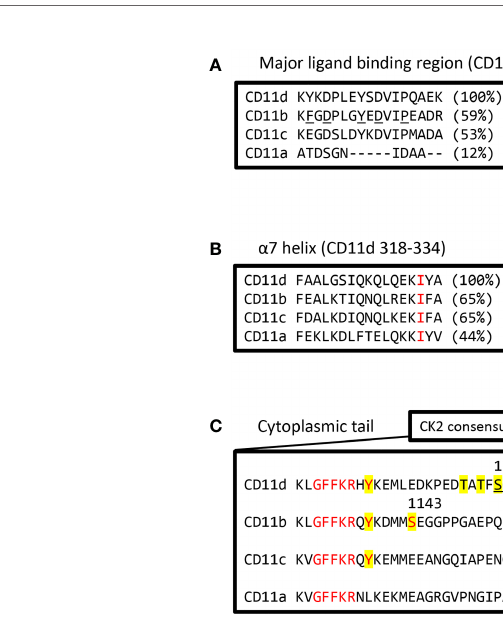
FIGURE 2 | Visual representation of a probable CD11d structure including amino acid homolog comparisons of key motifs. (A) Sequence comparison of the CD11d a -I domain major ligand binding region. The ligand binding CD11d a -I domain is highlighted by a hatched pattern. Residues determined to be important in the ligand binding pocket of CD11b are underlined and percent homology to CD11d is in brackets. Alignment and CD11b residue analysis performed in previous study (51). (B) Sequence comparison of the CD11 a 7 helix. An invariable isoleucine is highlighted in red and percent homology to CD11d is in brackets. Alignment was performed in previous study (17). Conformational changes to the a 7 helix within CD11d have been shown to alter ligand af fi nities, thus implying the presence of an open and closed a -I domain conformation (51). (C) Sequence comparison of complete CD11 cytoplasmic tails. Yellow denotes potential phosphorylation sites, red denotes conserved residues of interest, and the underlined sequence denotes a potential CK2 site. The GFFKR “ hinge ” motif is required to maintain the association of the CD11 and CD18 cytoplasmic tails (52). The constitutive phosphorylation of a serine residue is conserved across CD11a (Ser 1165 ) (53), CD11b (Ser 1143 ) (54), and CD11c (Ser 1158 ) (55). CD11d has a putative CK2 site at Ser 1148 -Cys 1154 using the consensus sequence (S-X-X-D/E-X-pS-P) (56). The same sequence would predict Ser 1153 to be constitutively phosphorylated as observed in other b 2 integrins. The function of the conserved GFFKR +2 tyrosine residue in CD11b-d is largely unde fi ned. The tyrosine appears to be embedded into the membrane during the inactive conformation, while exposed during the active conformation (57). Long isoform CD11a (NP_002200.2), CD11b (NP_001139280.1), CD11c (NP_000878.2), and CD11d (NP_001305114.1) amino acid sequences were acquired from the National Center for Biotechnology Information database (28 –